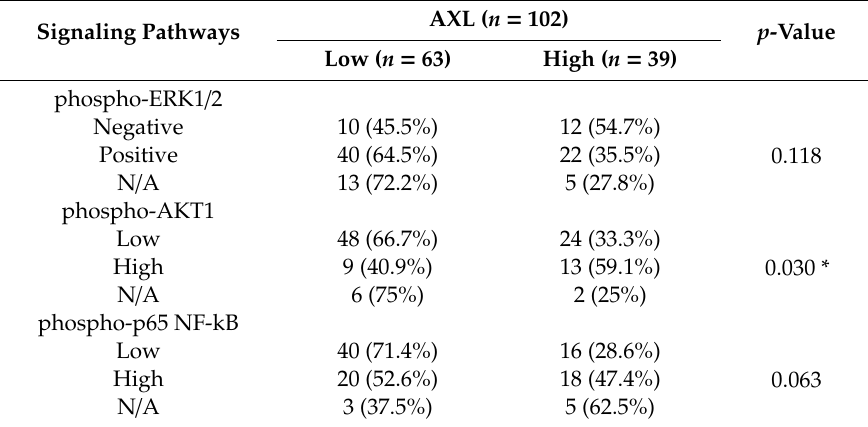
Table 5. Relation between AXL marker and phospho-ERK 1 / 2, phospho-AKT1, phospho-p65 NF-kB expression in thyroid cancer patients. * p <